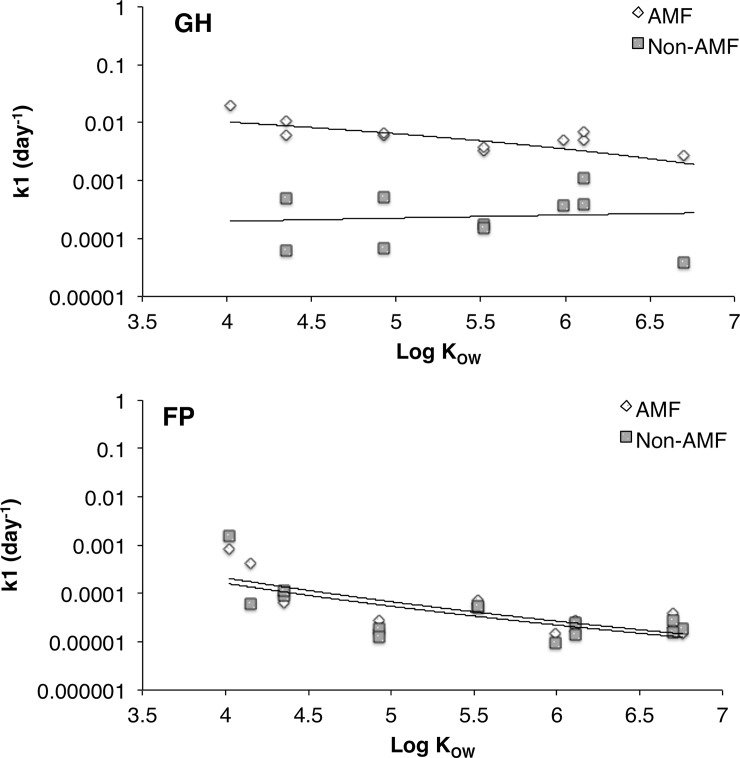
Uptake rates (k1) on a logarithmic scale measured in roots of arbuscular mycorrhizal fungi (AMF) and non-arbuscular mycorrhizal fungi (non-AMF) plants during week 10 (W10) (a) and year 1 (Y1) (b) of the greenhouse and field experiment plotted against the Log KOW’s of selected PAHs. In the greenhouse AMF roots show a significant negative relationship (slope = -0.17, r2 = -0.47, p = 0.014) while non-AMF roots showed no significance (slope = 0.0095, r2 = 0.00026, p = 0.97). In the field experiment, AMF roots showed a significant relationship (slope = -2.62, r2 = 0.36, p = 0.022) while non-AMF roots showed no significant relationship (slope = -1.80, r2 = 0.21, p = 0.098). Log KOW are given for the following PAHs: acenaphthene, fluorene, phenanthrene anthracene, fluoranthene, pyrene, benz[a]anthracene, chrysene, benzo[b]fluoranthene, benzo[k]fluoranthene, benzo[a]pyrene, indeno[1,2,3- cd]pyrene, dibenz[a,h]anthracene, and benzo[g,h,i]perylene.